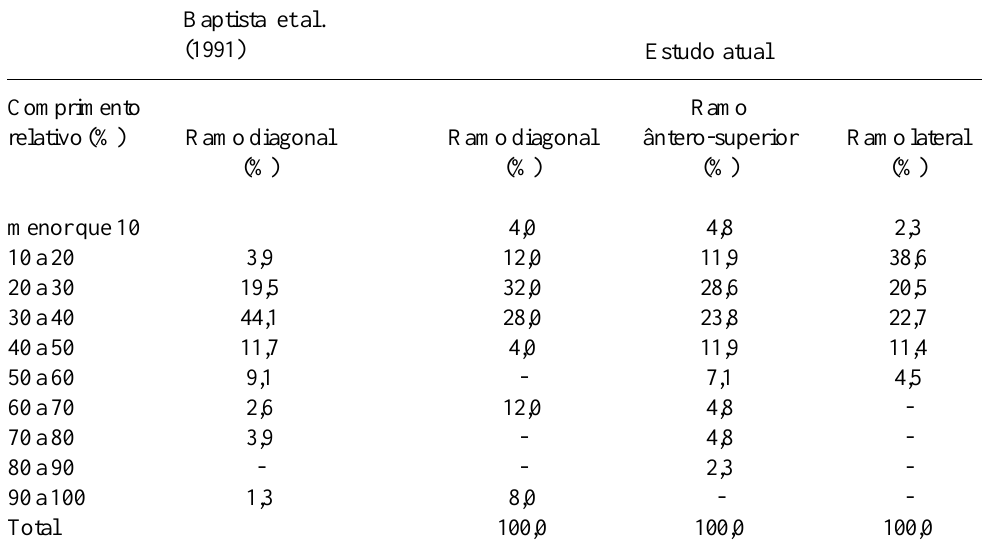
Tabela 7. Variação do comprimento dos ramos diagonal, ântero-superior e lateral em relação ao comprimento do ventrículo esquerdo.